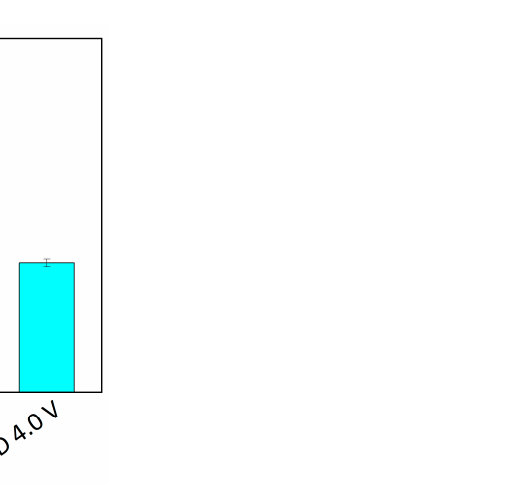
Figure 6. Comparison of the amount of abacavir degraded within 10 min by different methods. Conditions: Chemical oxidation using 3% hydrogen peroxide at 50 ◦ C, and all the electrochemical oxidations occurred at pH